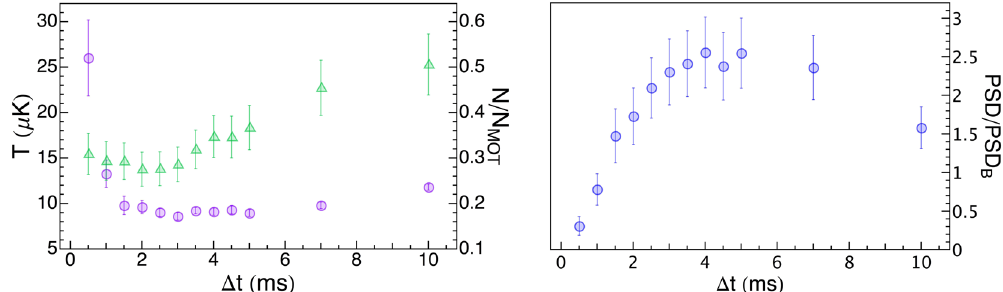
Figure 3. Optimization of molasses duration. Left: Temperature T (purple circles), fraction of remaining atoms N / N MOT (green triangles) and Right: normalized phase space density PSD / PSD B as a function of the duration Δ t of the grey molasses.